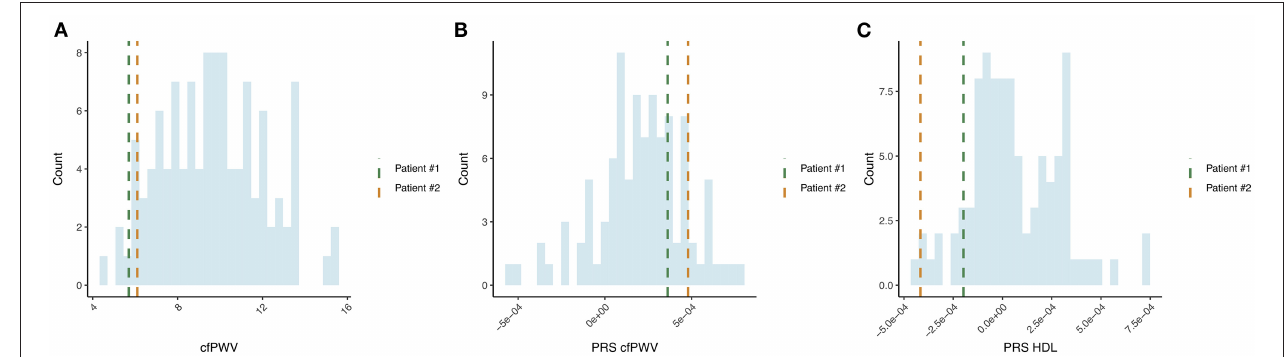
FIGURE 1 | Identification of individuals with SUPERNOVA phenotype and comparison of polygenic scores (PGS) for investigated patients and a control population of the same age and background. (A) Pulse wave velocity (PWV) measurements distribution in age-matched cohort of the Leningrad Siege survivors and two selected patients are highlighted; (B) PWV PGS, i.e., cfPWV; (C) High-density lipoproteins polygenic